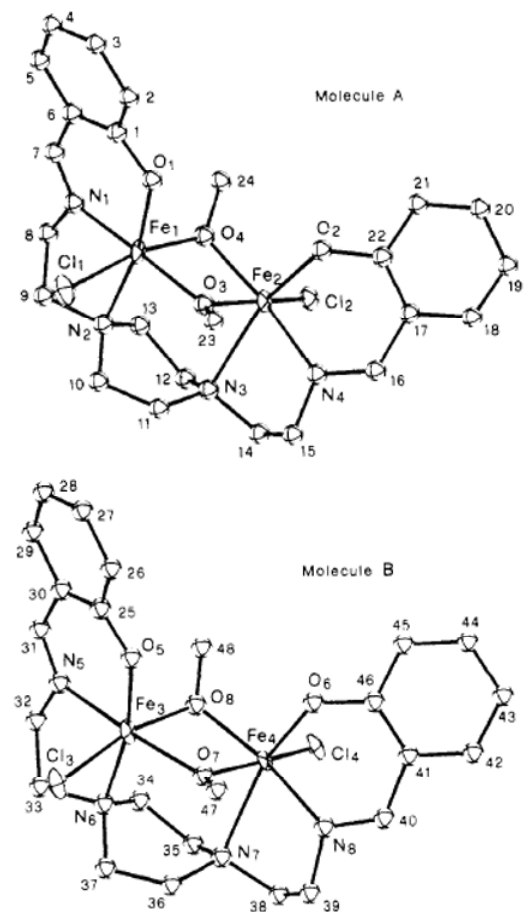
Figure 4. Structure of [Fe III